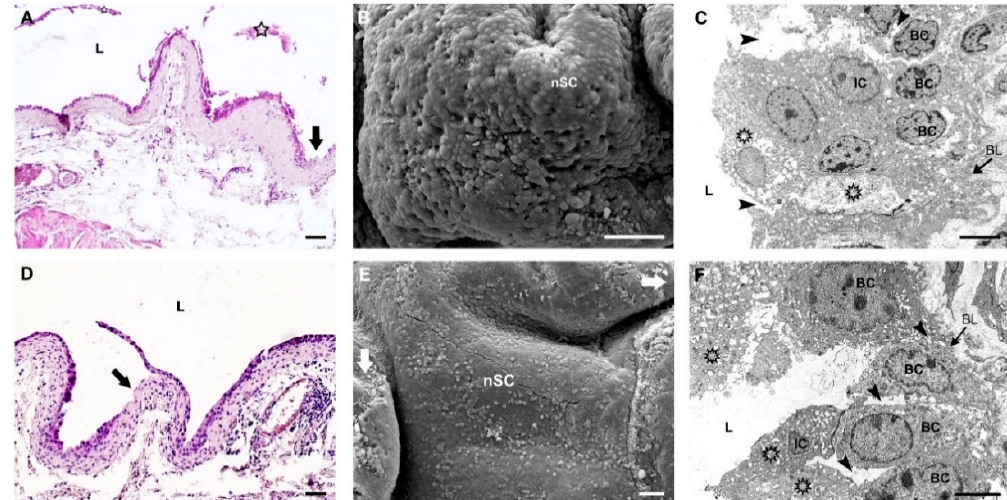
Figure 2. Representative micrographs of urothelial injury in young ( A – C ) and old ( D – F ) mice. The majority of the superficial cell layer (star frame in A ) is peeled off and smaller intermediate cells as new superficial cells (nSC) are exposed on the urothelial surface. At some areas of the urothelium, desquamation extends into deeper cell layers, where dilated intercellular spaces (arrowheads in C , F ), necrotic urothelial cells (asterisk frames in C , F ), and exposed basal lamina are present (arrows in A , D , E ). ( A , D ) Hematoxylin and eosin (H&E) staining; ( B , E ) Scanning electron microscopy; ( C , F ) Transmission electron microscopy. L-lumen of the urinary bladder, BL-basal lamina, IC-intermediate cells, BC-basal cells. Scale bars: 100 µm ( A , B , D , E ); 6 µm ( C , F ).